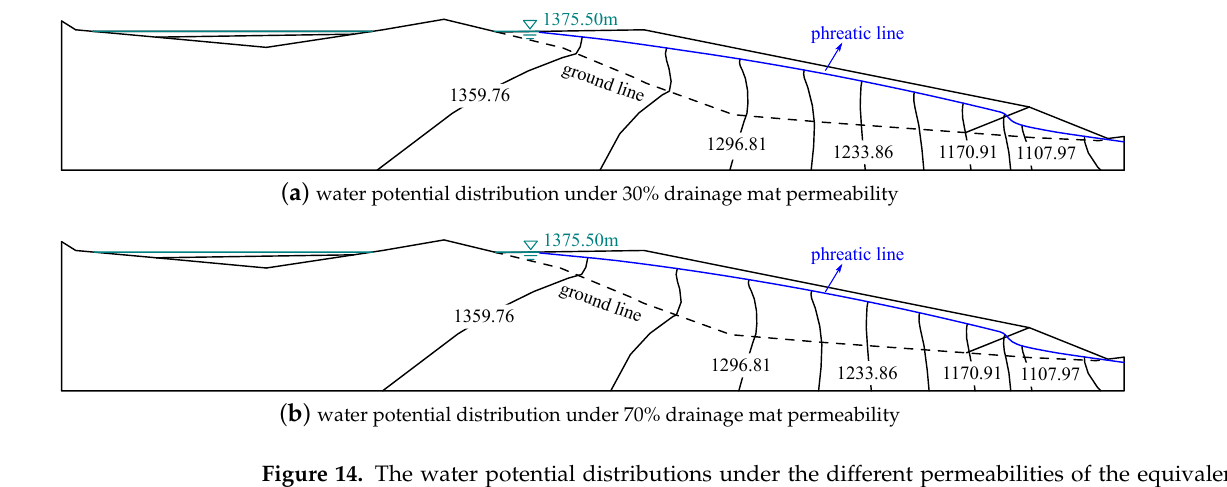
Figure 14. The water potential distributions under the different permeabilities of the equivalent drainage structure (m). The phreatic line will be lifted up if the drainage mat is damaged. Under the different tailings discharge speeds (2.0 × 10 4 , 3.0 × 10 4 , and 4.0 × 10 4 t/d),